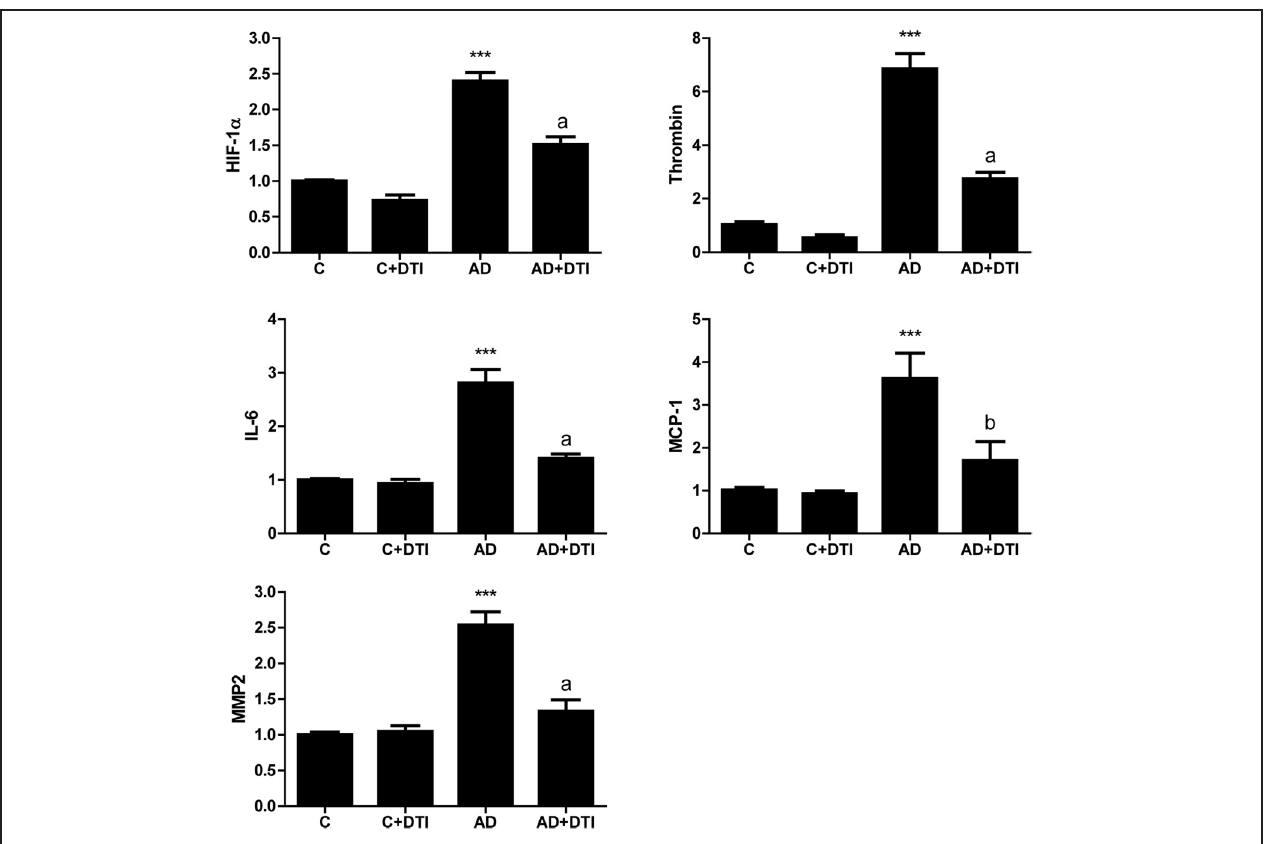
FIGURE 3 | Brain tissues from control, control + DTI, AD and AD + DTI mice were homogenized, total RNA collected, reverse transcribed and mRNA expression of HIF-1 α , thrombin, IL-6, MCP-1, and MMP2